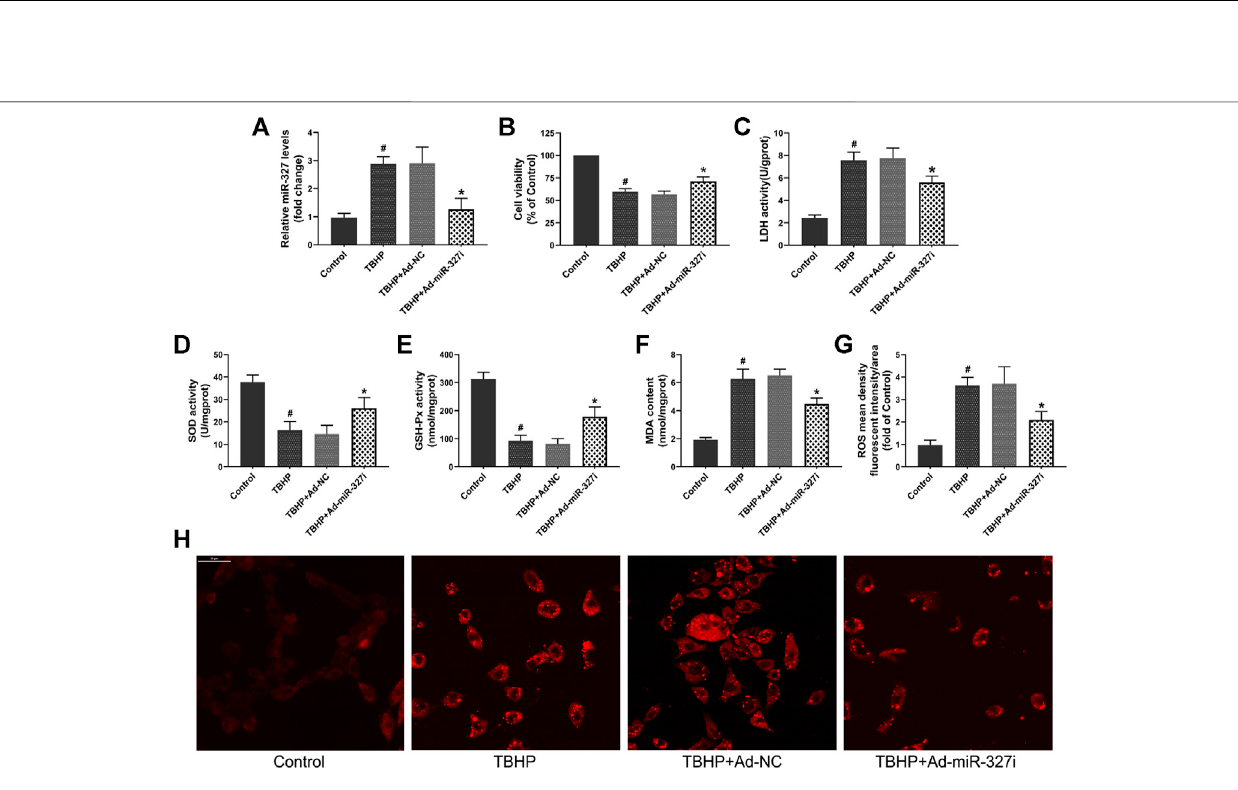
Frontiers in Pharmacology |